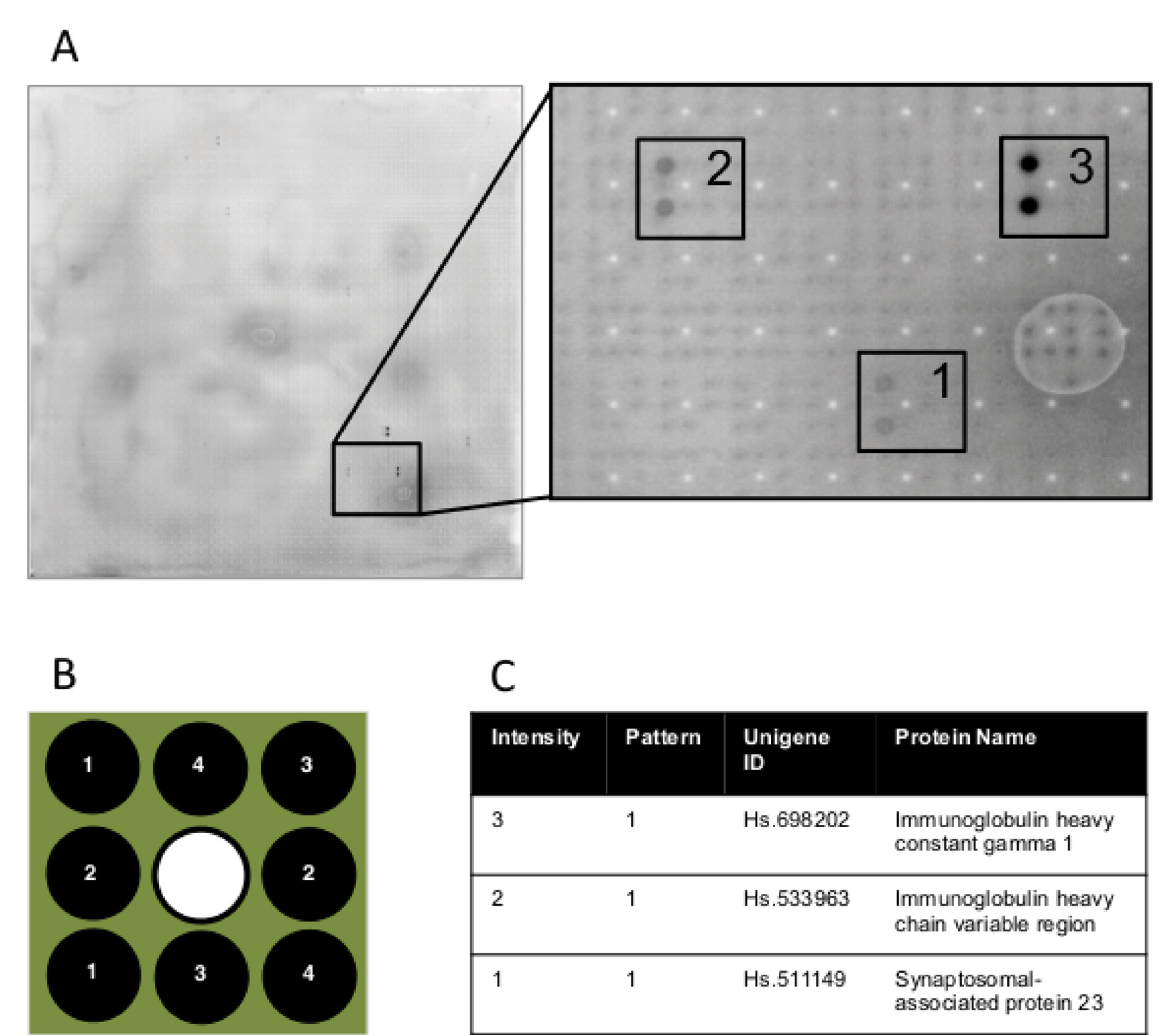
Figure 1. Cross-reactivity of rabbit anti-chicken IgY and goat anti-rabbit IgG identified by protein array screening. ( A ) Image of a whole protein array and a representative section illustrating antibody-antigen binding at three different signal intensities; 3 = strong, 2 = intermediate and 1 = weak. ( B ) The proteins are arranged in a 3×3 pattern on the array and all proteins are arrayed twice and appear as duplicate spots in a particular pattern within a block after a successful hybridization. ( C ) Description of proteins chosen as examples provided on the representative array image above; signal intensities, patterns, Unigene IDs and protein names are